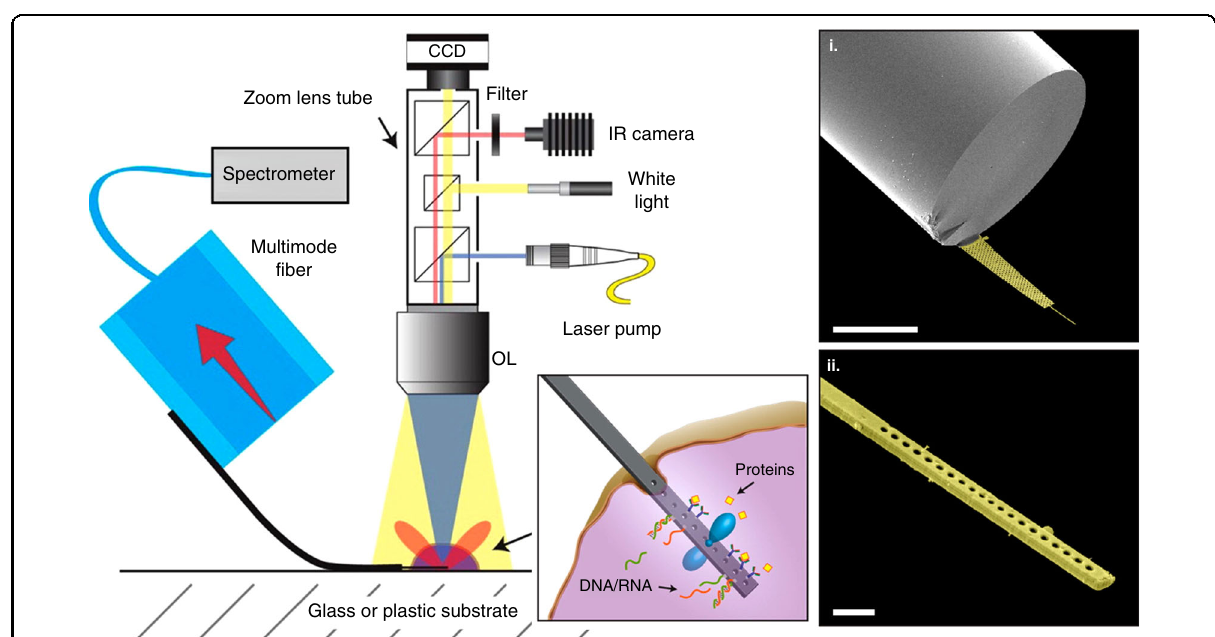
Fig. 2 Schematic drawing of the optical setup used for remote readout with active GaAs semiconductor photonic crystal nanocavities doped with InAs QDs. The box depicts some of the potential sensing modes, e.g., label-free protein detection (left panels). False-colour SEM micrographs of an actual photonic crystal used for streptavidin (SA)-biotin-binding experiments (right panels i and ii) 125